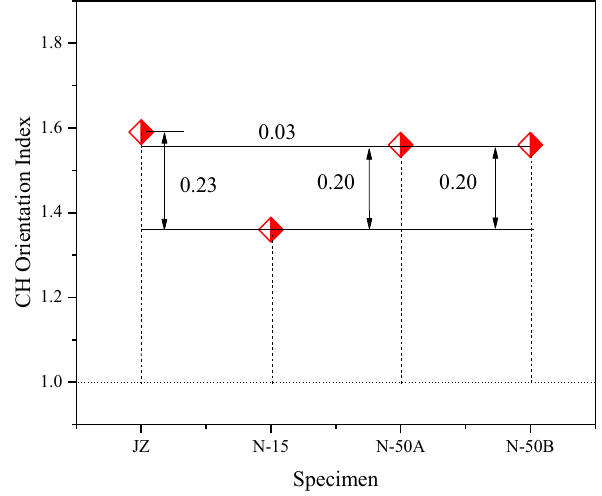
Figure 5: CH orientation index for each specimen at 1